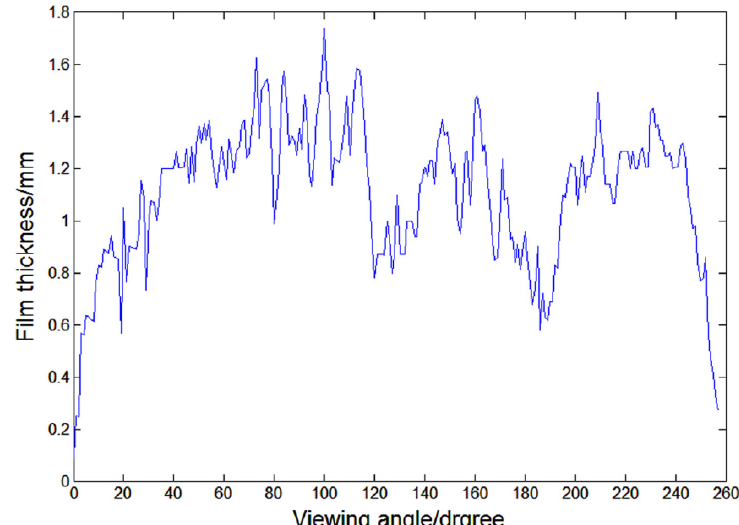
Figure 13. The unsymmetrical circumferential film thickness determined using PLIF, adapted with permission from [54], 2019, John Wiley and Sons.